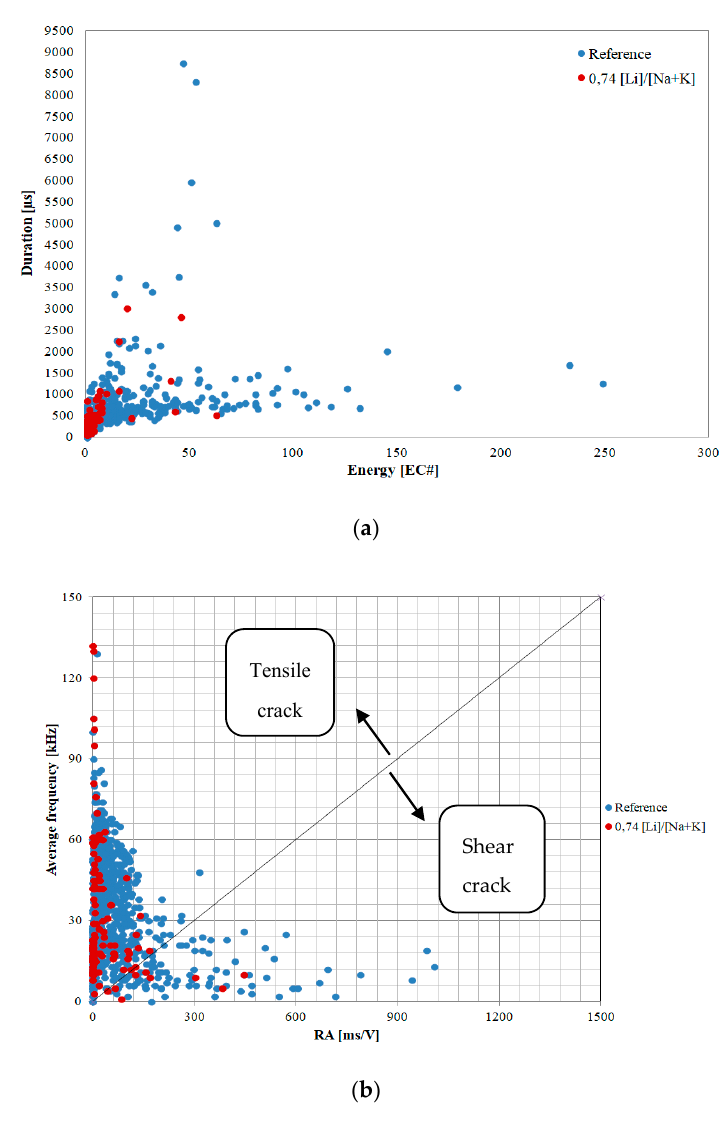
Figure 5. Duration versus energy ( a ) and average frequency versus RA index ( b ) for AE events of mortar samples.